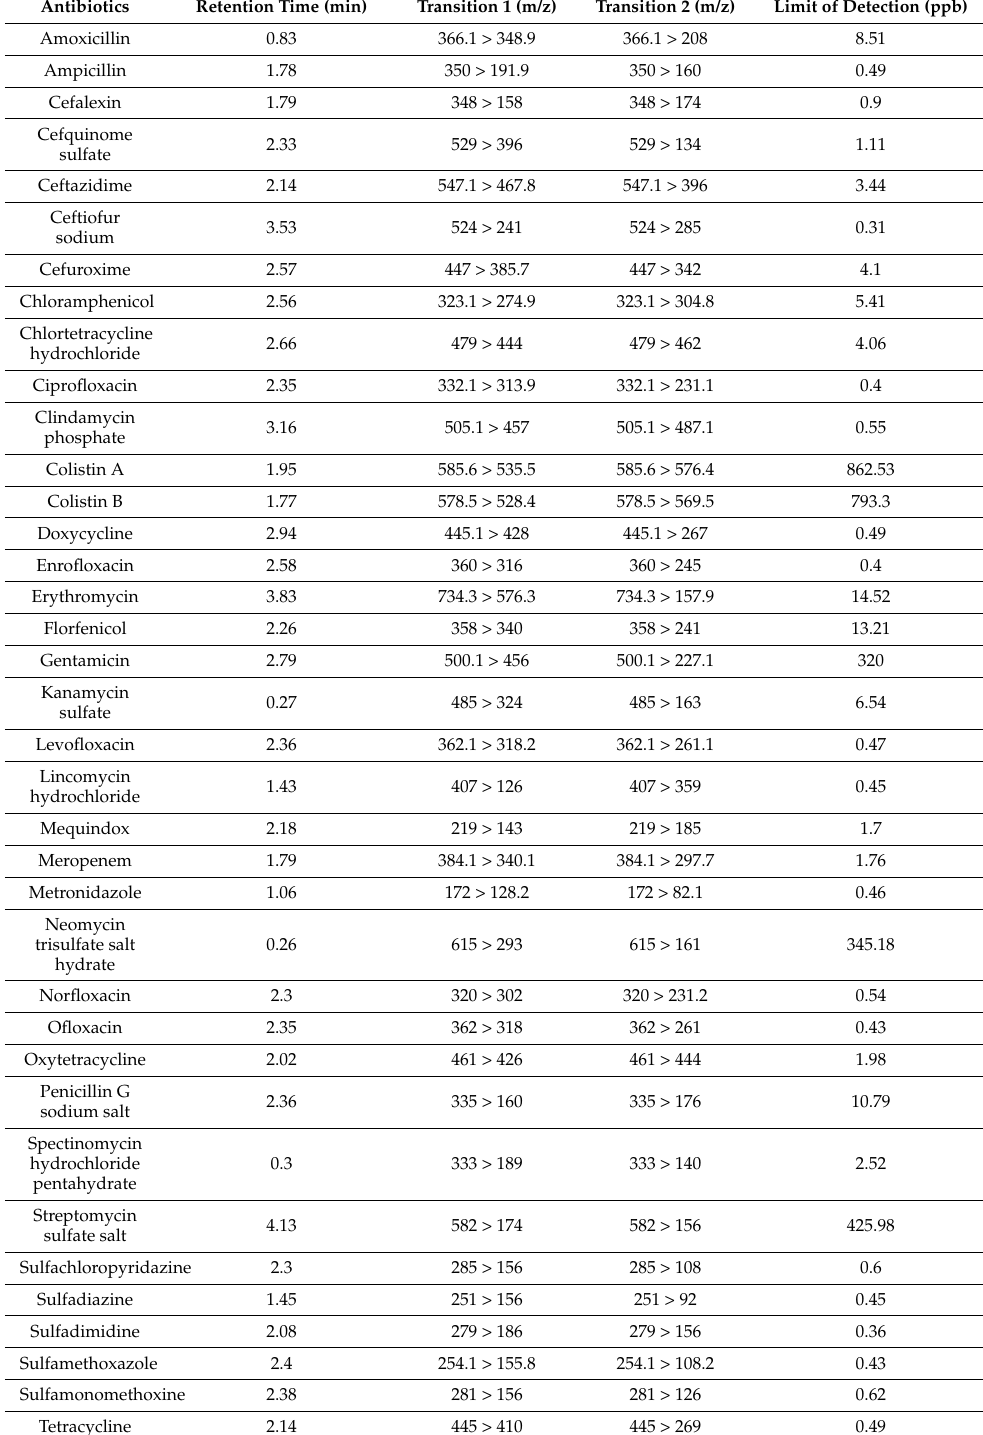
Table 2. Liquid chromatography and mass spectrometry of 43